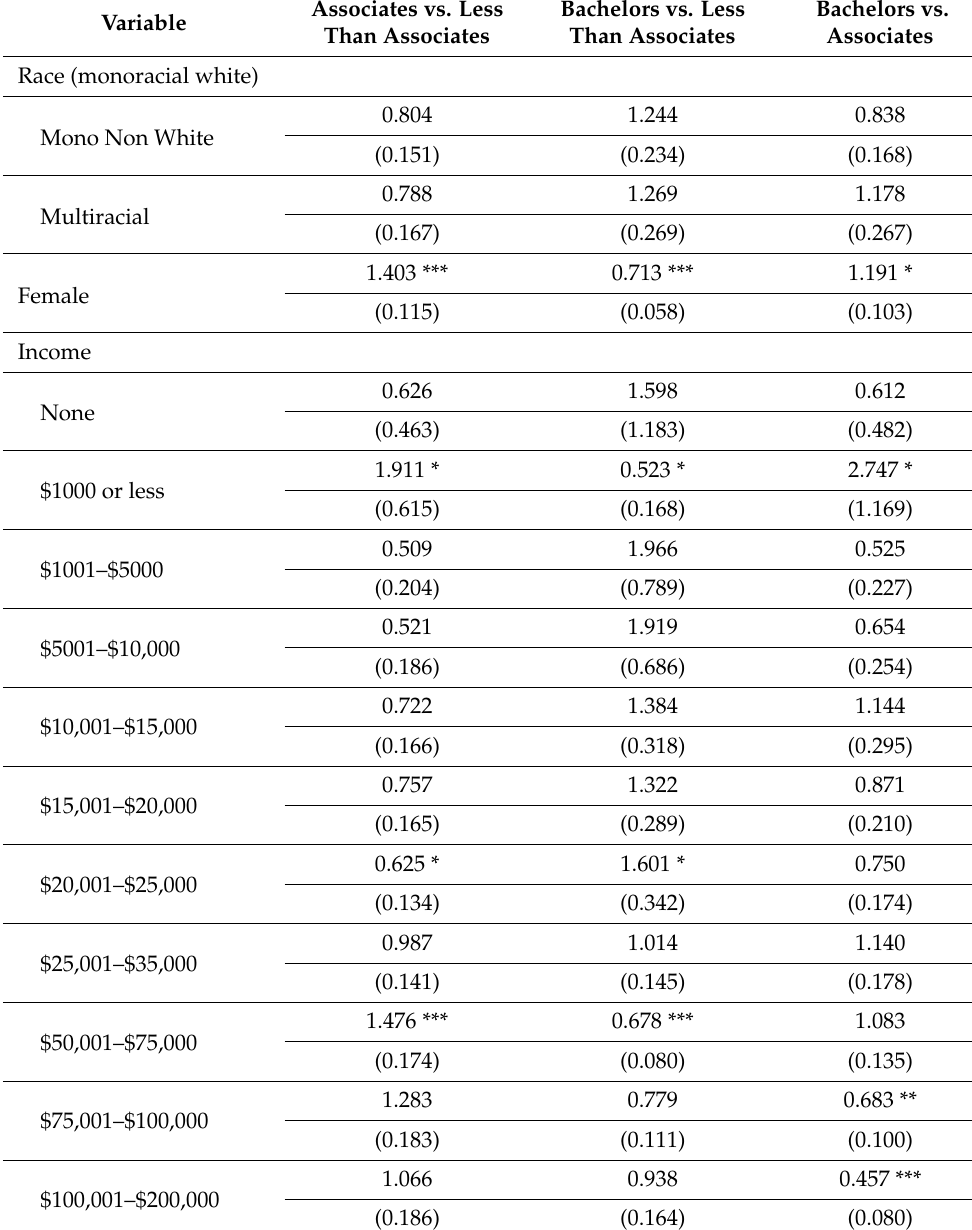
Table A3. Multinomial Regression of Degree